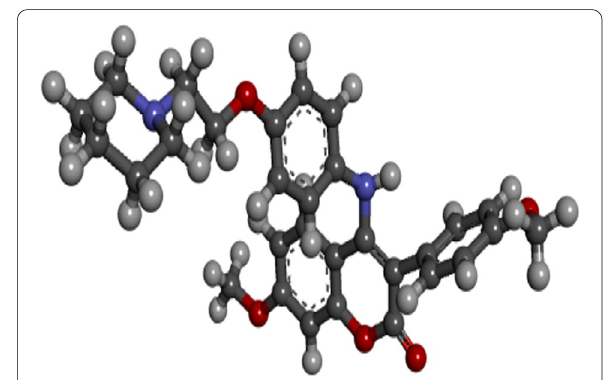
Fig. 10 3D structure of compound